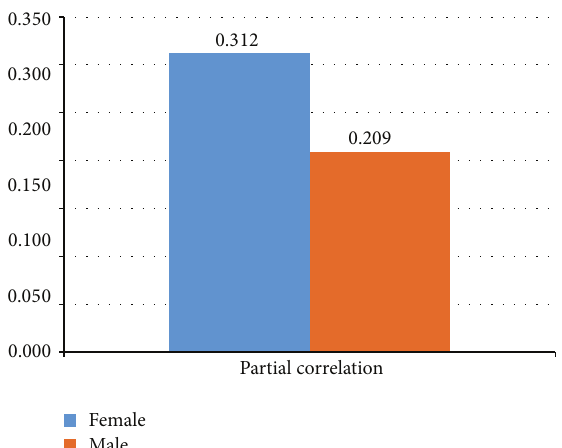
Figure 2: Partial correlation ( 𝑟 ) of ApoB/ApoA-I ratio with HOMA2-IR (controlling by age, SP, DP, WC, BMI, HDL-C, LDL-C, FG, TG, and TC). Partial correlation: Spearman partial correlation coefficient 𝑟 ; 𝑃 (2-tailed) < .0001. ApoB/ApoA-I ratio: apolipopro- tein B/apolipoprotein A-I ratio, IR: insulin resistance, SP: systolic blood pressure, DP: diastolic blood pressure, WC: waist circum- ference, BMI: body mass index, HDL-C: high-density lipoprotein cholesterol, LDL-C: low-density lipoprotein cholesterol, FG: fasting glucose, TG: triglyceride, TC: total cholesterol, and HOMA2-IR: homeostasis model assessment of insulin